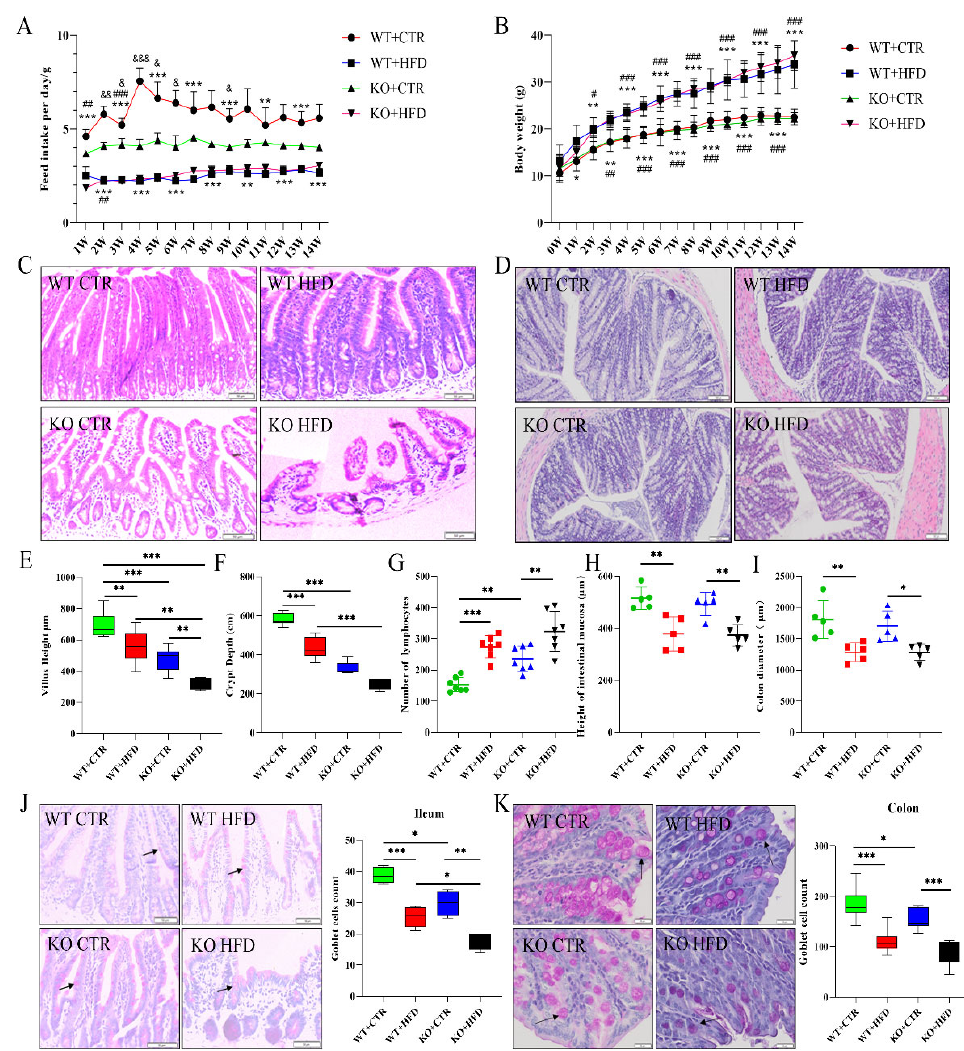
Figure 2. TRIM67 deletion has no effect on body weight and exacerbates the pathological damage. ( A ) Average weekly feed intake of mice during modeling WT CTR compared to WT HFD ( n = 8), * p < 0.05, ** p < 0.01, *** p < 0.001; KO CTR compared to KO HFD, # p < 0.05, ## p < 0.01, ### p < 0.001; WT CTR compared to KO CTR, & p < 0.05, && p < 0.01, &&& p < 0.001. ( B ) Average weekly weight gain of mice WT CTR compared to WT HFD ( n = 11), * p < 0.05, ** p < 0.01, *** p < 0.001; KO CTR compared to KO HFD, # p < 0.05, ## p < 0.01, ### p < 0.001. ( C ) H&E results of ileum indicating the pathological damage in different groups as compared to WT CTR diet group. ( D ) Colon H&E staining results displaying the difference in lymphocyte number, height of intestinal mucosa and colon diameter in different groups. ( E , F ) Quantification of villus height and crypt depth in ileum ( n = 5). ( G – I ) The quantification of lymphocyte number, height of intestinal mucosa and diameter in colon ( n = 5). ( J , K ) PAS staining results in ileum and colon and graphical representation of goblet cell count. Black arrows showing the goblet cells in ileum and colon ( n = 5). The data are expressed as mean ± SEM. Significance was determined by one ‐ way ANOVA (* p < 0.05, ** p < 0.01, *** p < 0.001).